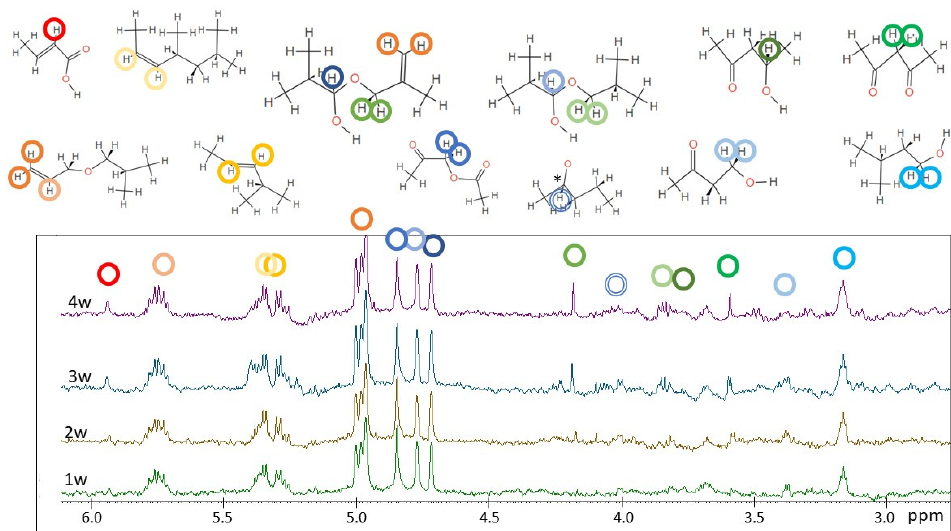
Figure 9. Enlargement of the 1 H NMR spectra of PP after 1 w, 2 w, 3 w, and 4 w of irradiation, from 2.8 to 6.1 ppm. The main 1 H NMR signals and the corresponding assignments to compounds with the given molecular structure are shown. The correspondence between each signal and the proton/protons on the molecular sketches is put in evidence through colored circles. See the text for further explanations.